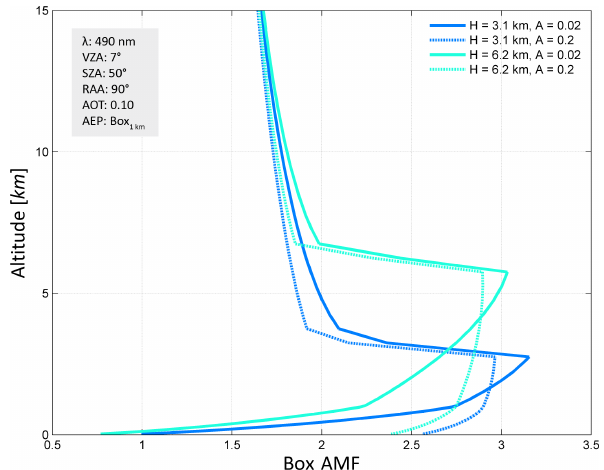
Figure 9. Height-dependent box AMFs assessing the vertical sen- sitivity to NO 2 , illustrated for the aircraft altitude of the Cessna 207T D-EAFU ( H = 3 . 1kma.g.l.) and the Dornier DO-228 D- CFFU ( H = 6 . 2kma.g.l.), for both low and high surface reflectance scenarios.